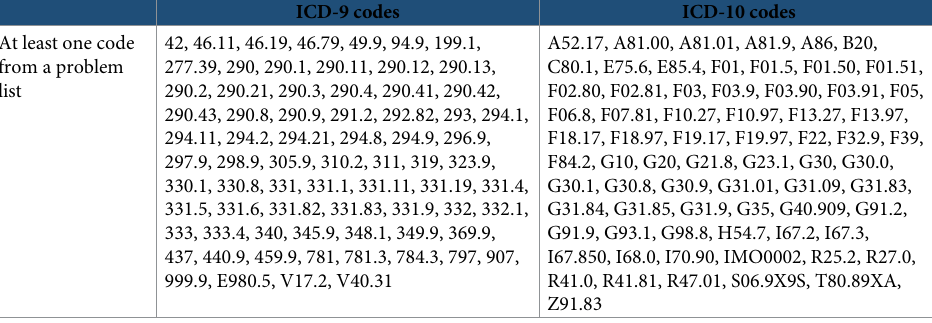
Table 1. Dementia international classification of diseases 9 th and 10 th revision (ICD-9 and ICD-10) codes. ICD-9 codes ICD-10